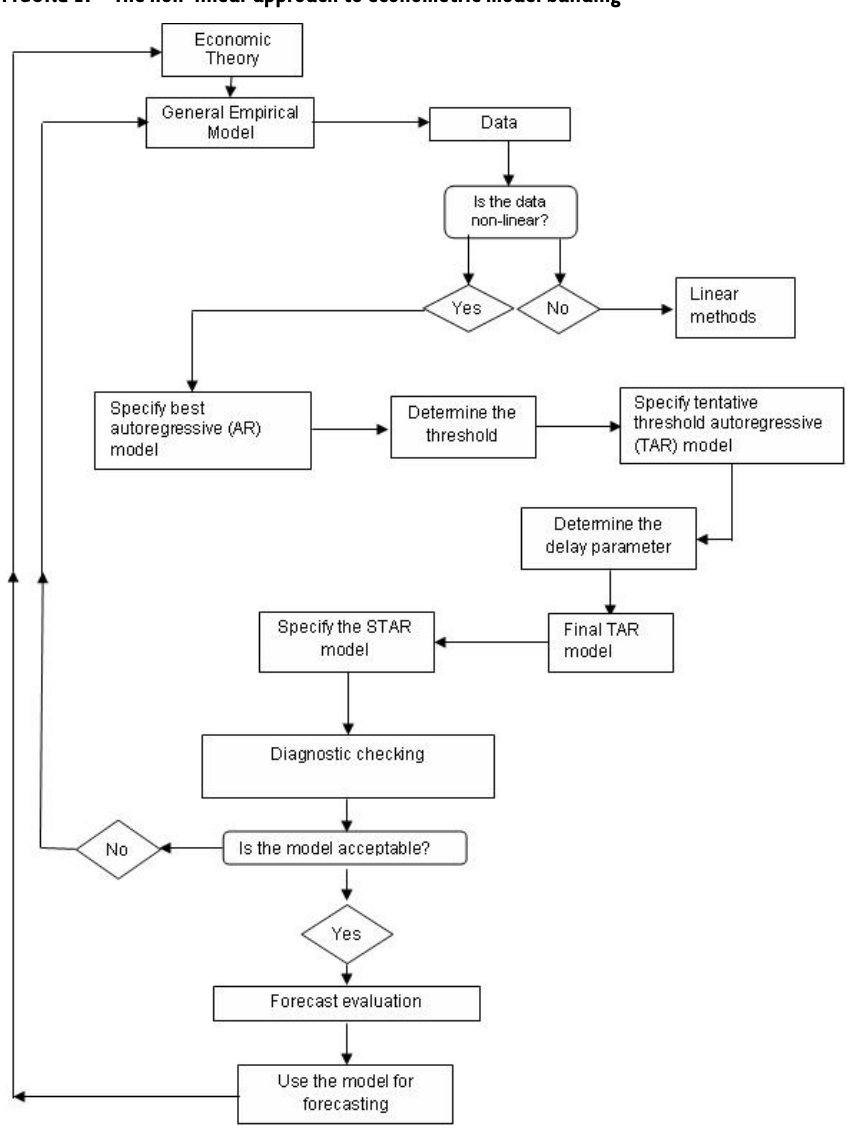
FIGURE 1: The non-linear approach to econometric model